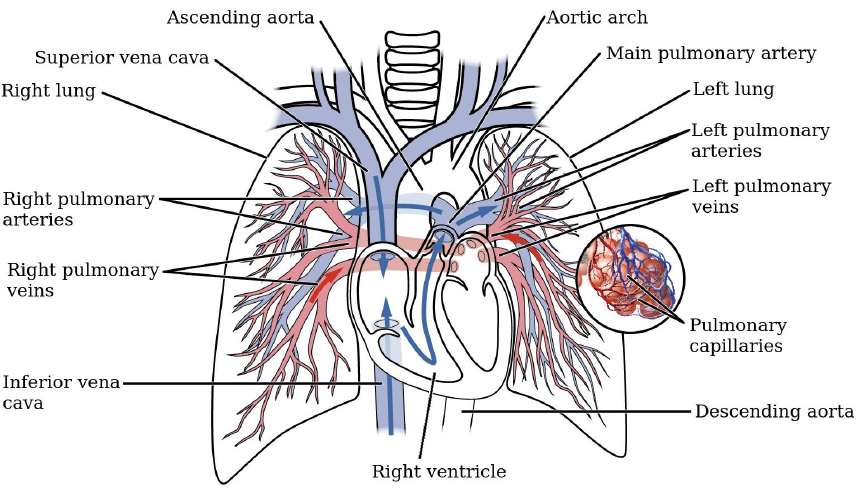
Figure 1. Schematic of the pulmonary circuit (adapted from